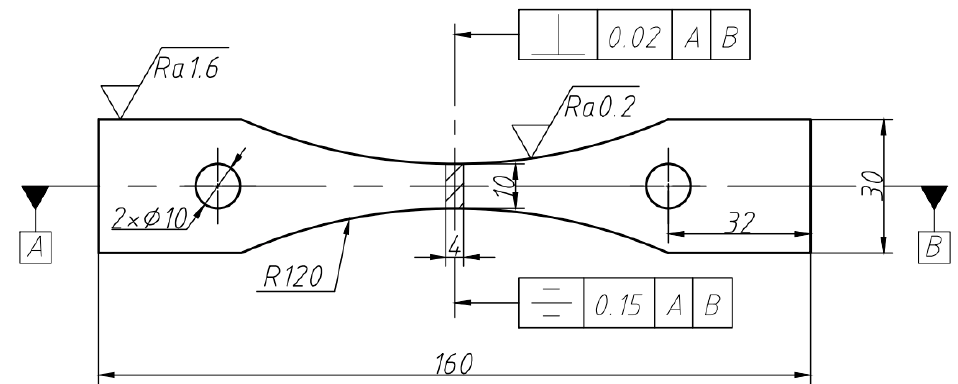
Figure 1. Engineering drawing of sample for corrosion fatigue experiment.